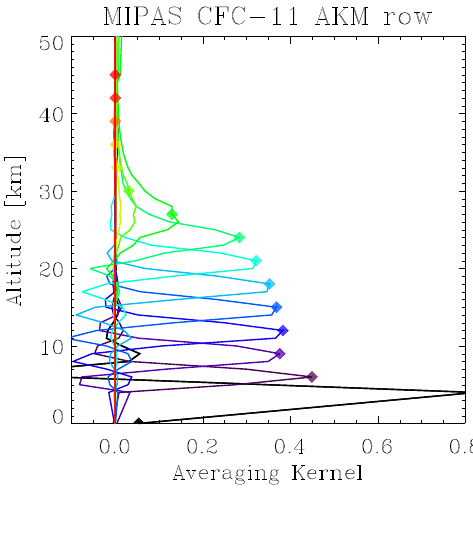
11 Table 1. Scan sequences for MIPAS FR and RR measurements (Dudhia, 2012). The RR-Nominal mode heights are latitude depen- dent.